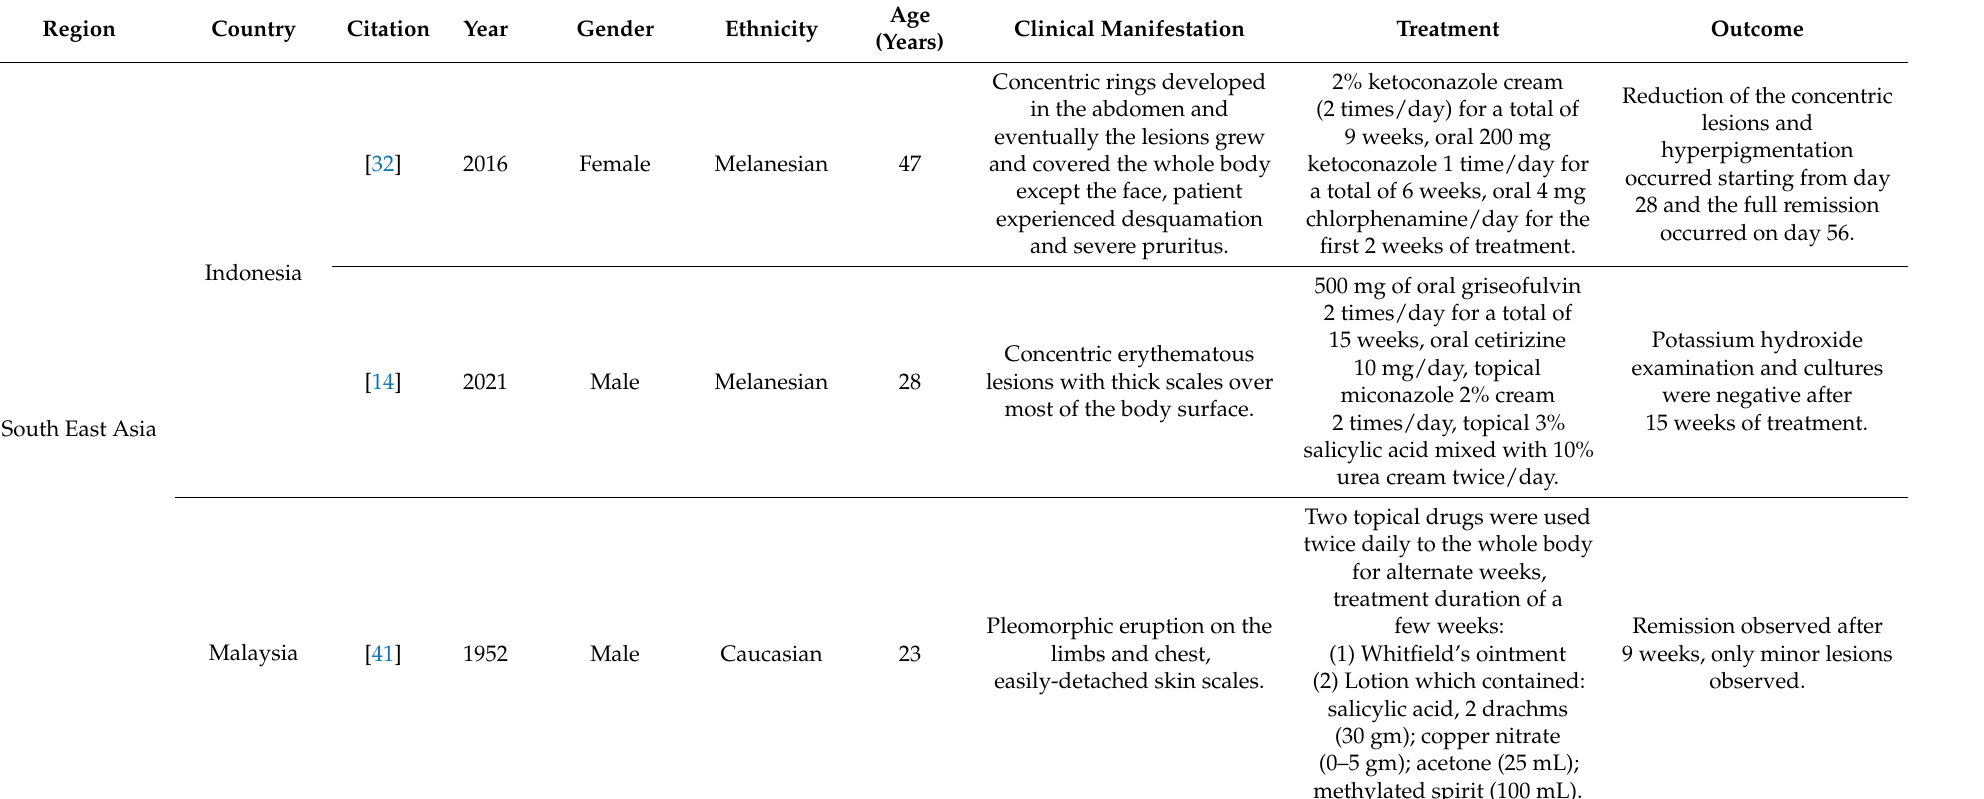
Table A2. Compilation of the collected case report of tinea imbricata around the